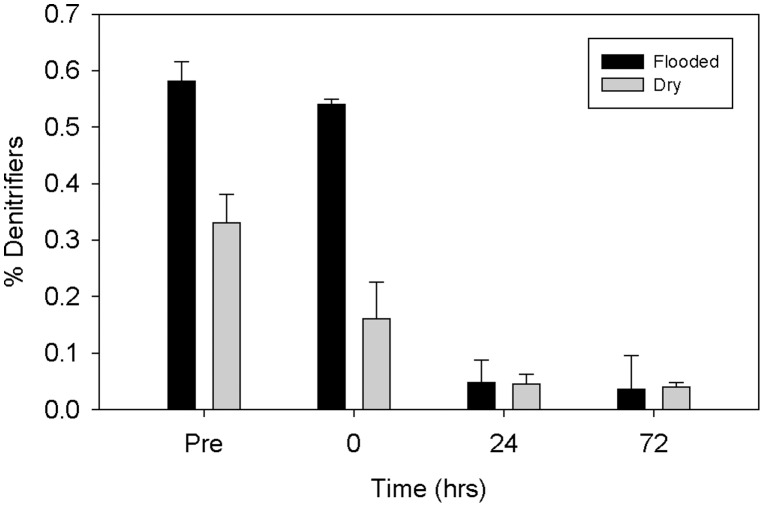
Mean denitrifier abundance (ratio of nosZ: 16S rRNA copy number) by treatment over time.Error bars indicate +1 SE.